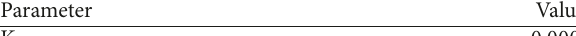
Table 7: PI coefficients for boost converter. Parameter Value K P 0.0005 K i